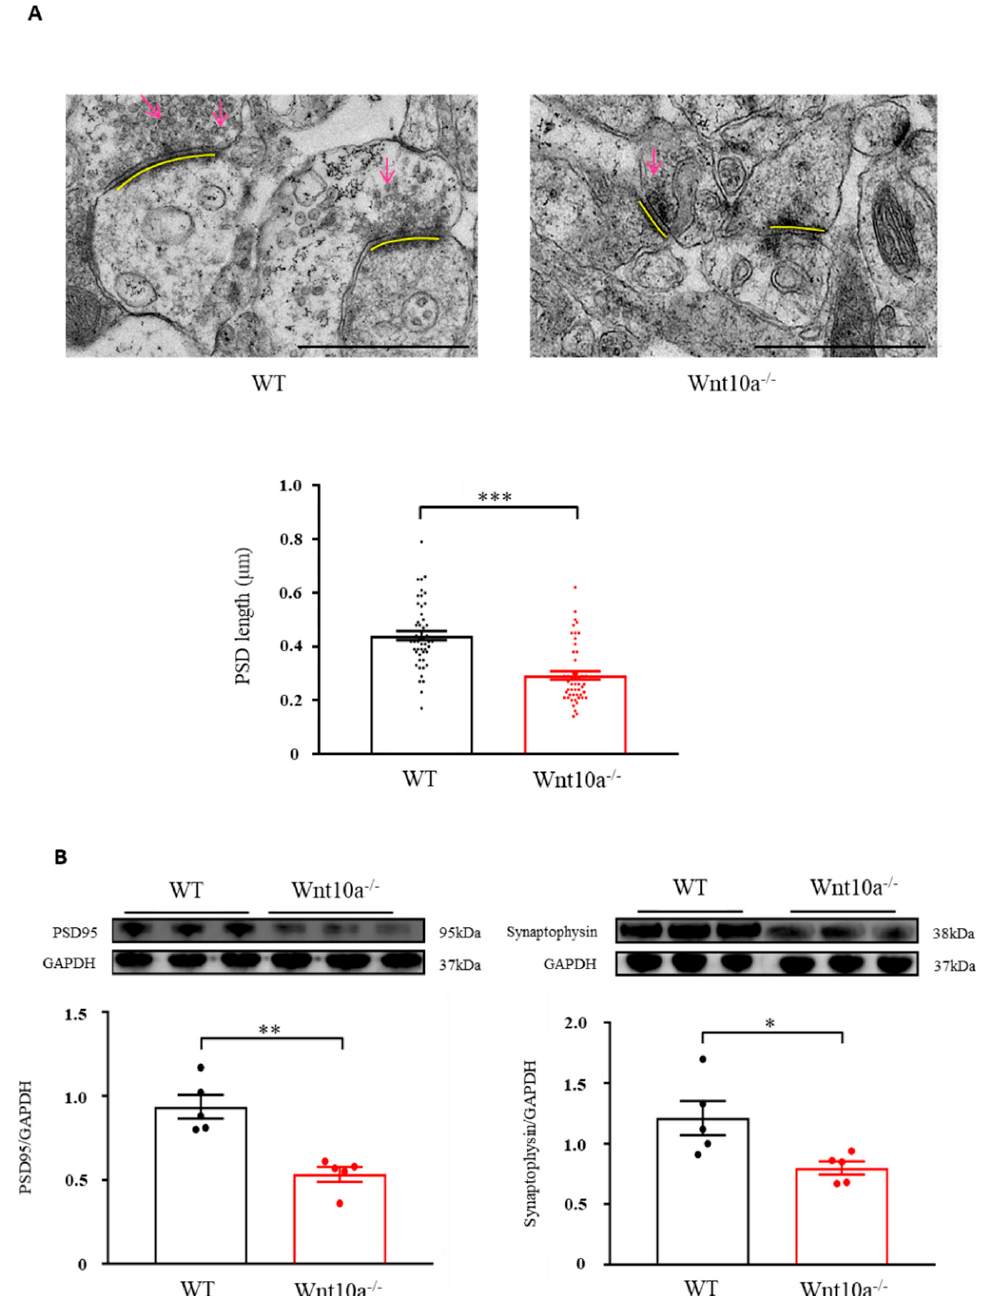
Figure 5. Electron microscopic images of synapses and the protein expression of PSD95 and synap- tophysin in the hippocampus. The presynaptic vesicles were decreased, and the PSD length was significantly shorter in Wnt10a -/- mice compared with WT mice ( A ). Arrows: presynaptic vesicles; yellow bars: PDS. Scale bars = 1 µ m. The protein expressions of PSD95 and synaptophysin were significantly lower in Wnt10a -/- mice than in WT mice ( B ). Data are expressed as mean ± SEM; n = 5/group; * p < 0.05, ** p < 0.01, and *** p < 0.001.